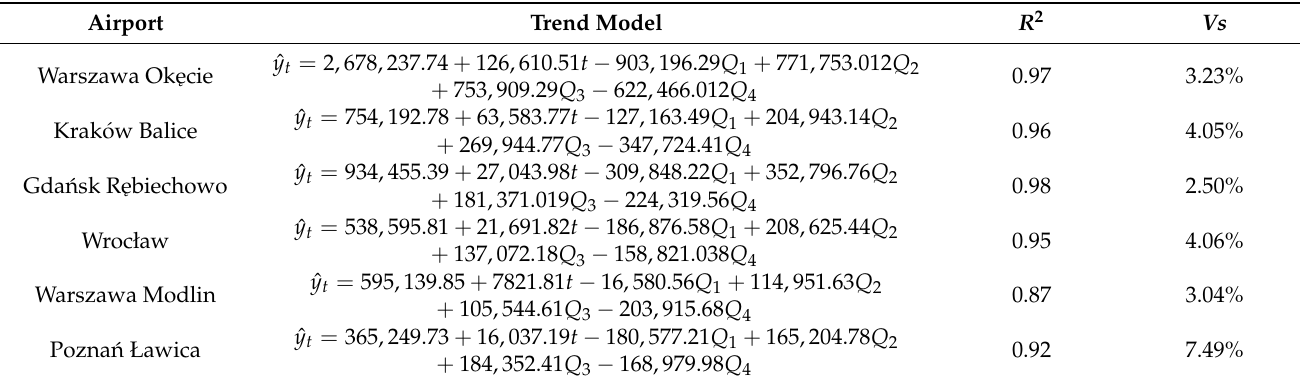
Table 7. Trend models with seasonality.